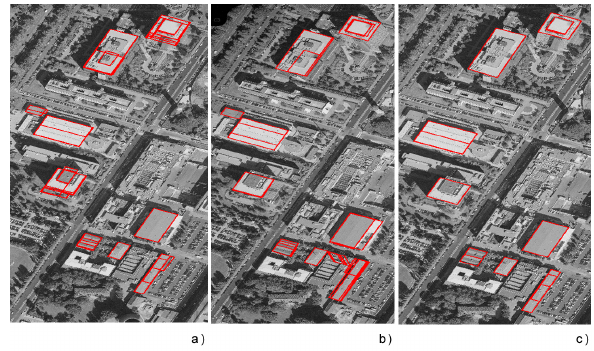
Figure 4: Result of image matching. a) left image after build- ing detection marked by red color; b) right image after building detection marked by red color; c) result of image matching is marked by red color